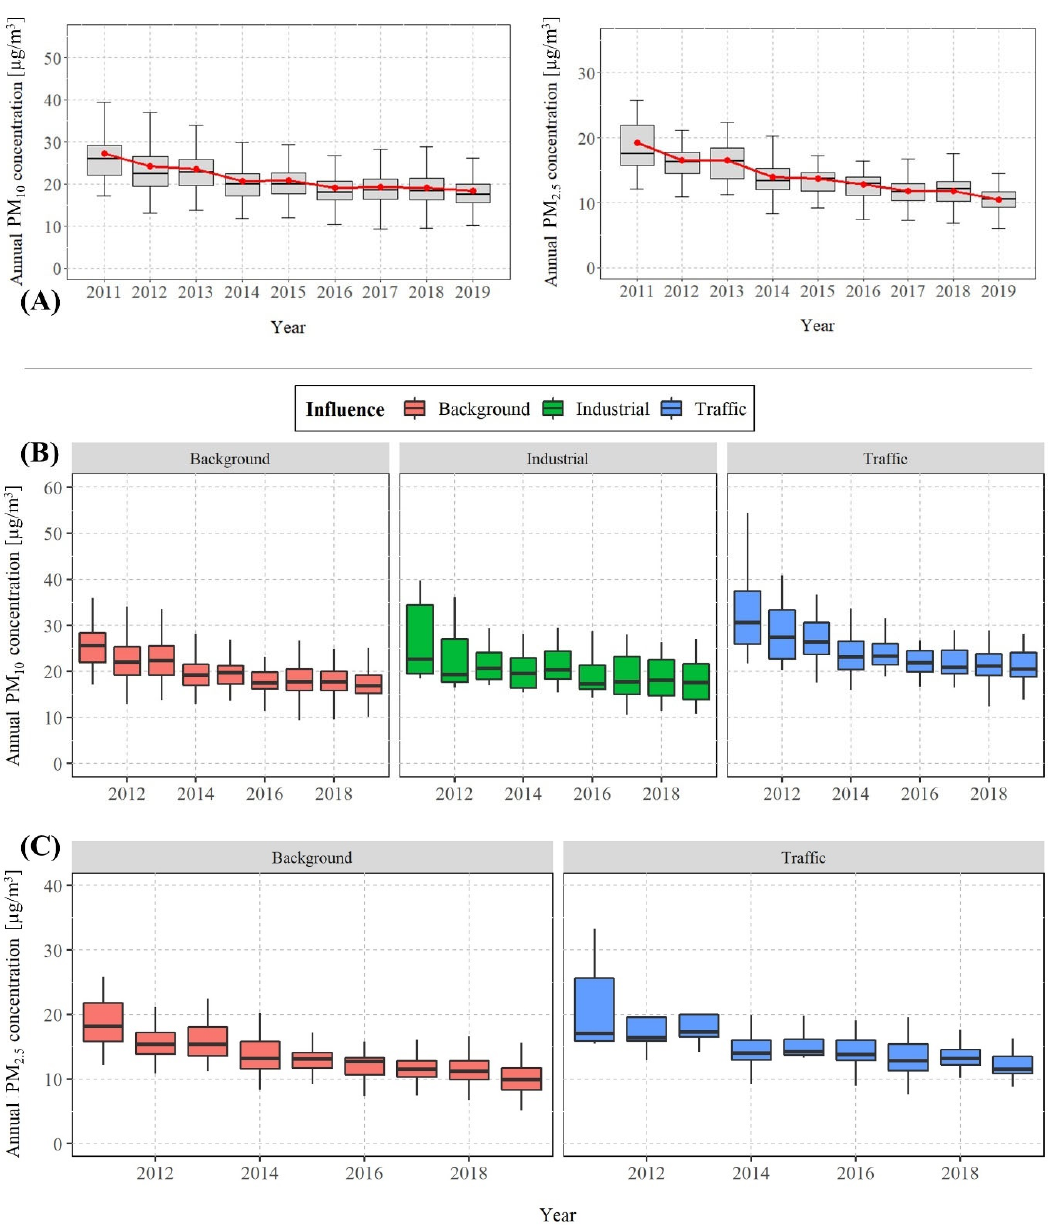
Figure 2. PM 10 and PM 2.5 general evolution ( A ) as a function of the years (with mean annual concentrations following the red line) and detail of the influence for PM 10 ( B ) and PM 2.5 ( C ).